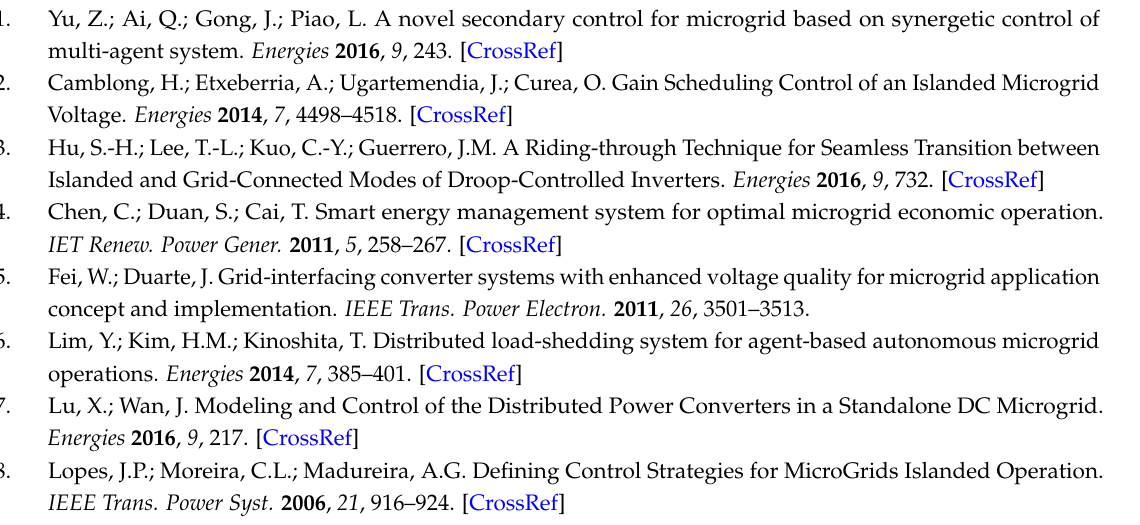
h P ; and ( d ) DGs active power over time. Figure 17. Variations of ( a ) loads; ( b ) frequency; ( c ) h ( P ) ; and ( d ) DGs active power over i i i i